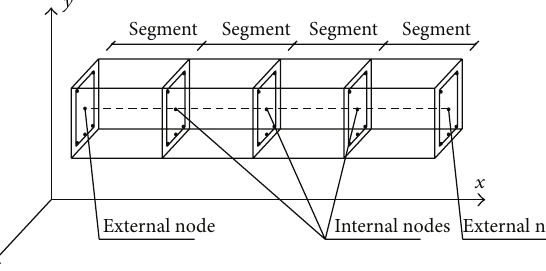
Figure 2: Segments and external and internal nodes for